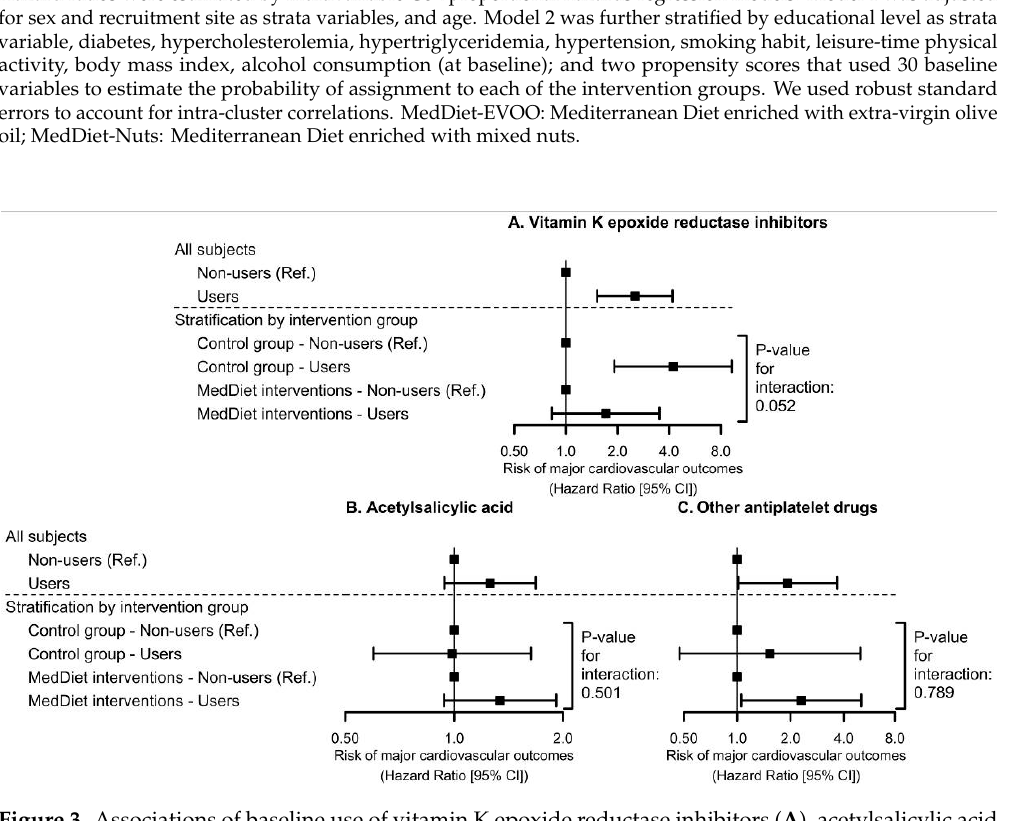
Figure 3. Associations of baseline use of vitamin K epoxide reductase inhibitors ( A ), acetylsalicylic acid as antiplatelet agent ( B ), and non-acetylsalicylic antiplatelet drugs ( C ) with the risk of